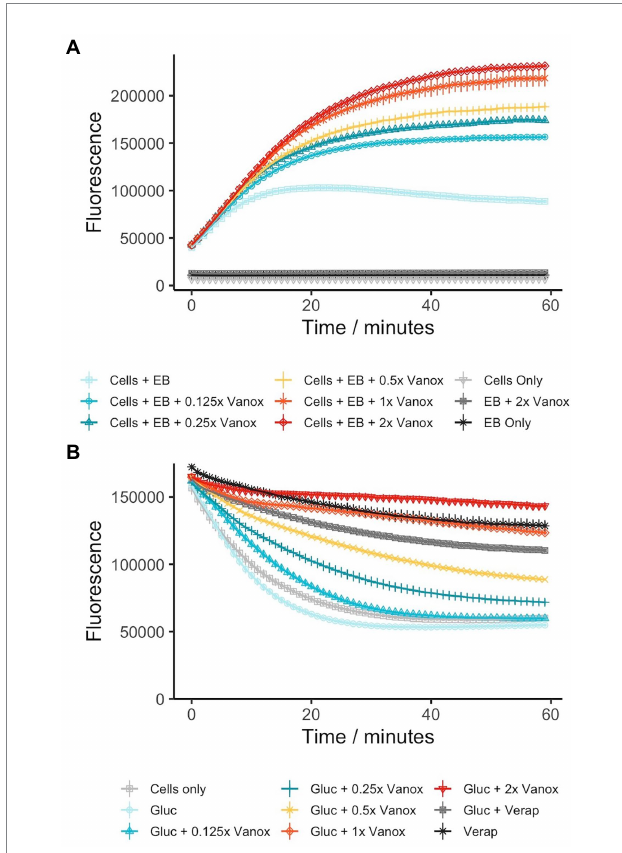
FIGURE 2 Vanoxerine inhibits the efflux of ethidium bromide from M. smegmatis (A) Vanoxerine treatment leads to accumulation of ethidium bromide in M. smegmatis at sub-inhibitory concentrations. M. smegmatis (OD 600 = 0.8) was re-suspended in PBS + 0.05% tween-80 + 0.4% glucose +0.625 μ g/ml ethidium bromide. The cells were immediately added to a 96-well plate containing varying vanoxerine concentrations and the fluorescence was monitored. MIC = 26 μ g/ml. N = 3. (B) Vanoxerine prevents the efflux of ethidium bromide in M. smegmatis . Verapamil was used to cause ethidium bromide accumulation in M. smegmatis for 1 h. Then the cells were resuspended in fresh PBS and either added directly, or mixed with glucose to 0.4% before adding, to a 96-well plate containing DMSO, vanoxerine or verapamil. The fluorescence was monitored to look at efflux of ethidium bromide. MIC = 26 μ g/ml. N = 3. EB, ethidium bromide; vanox, vanoxerine; gluc, glucose; verap,